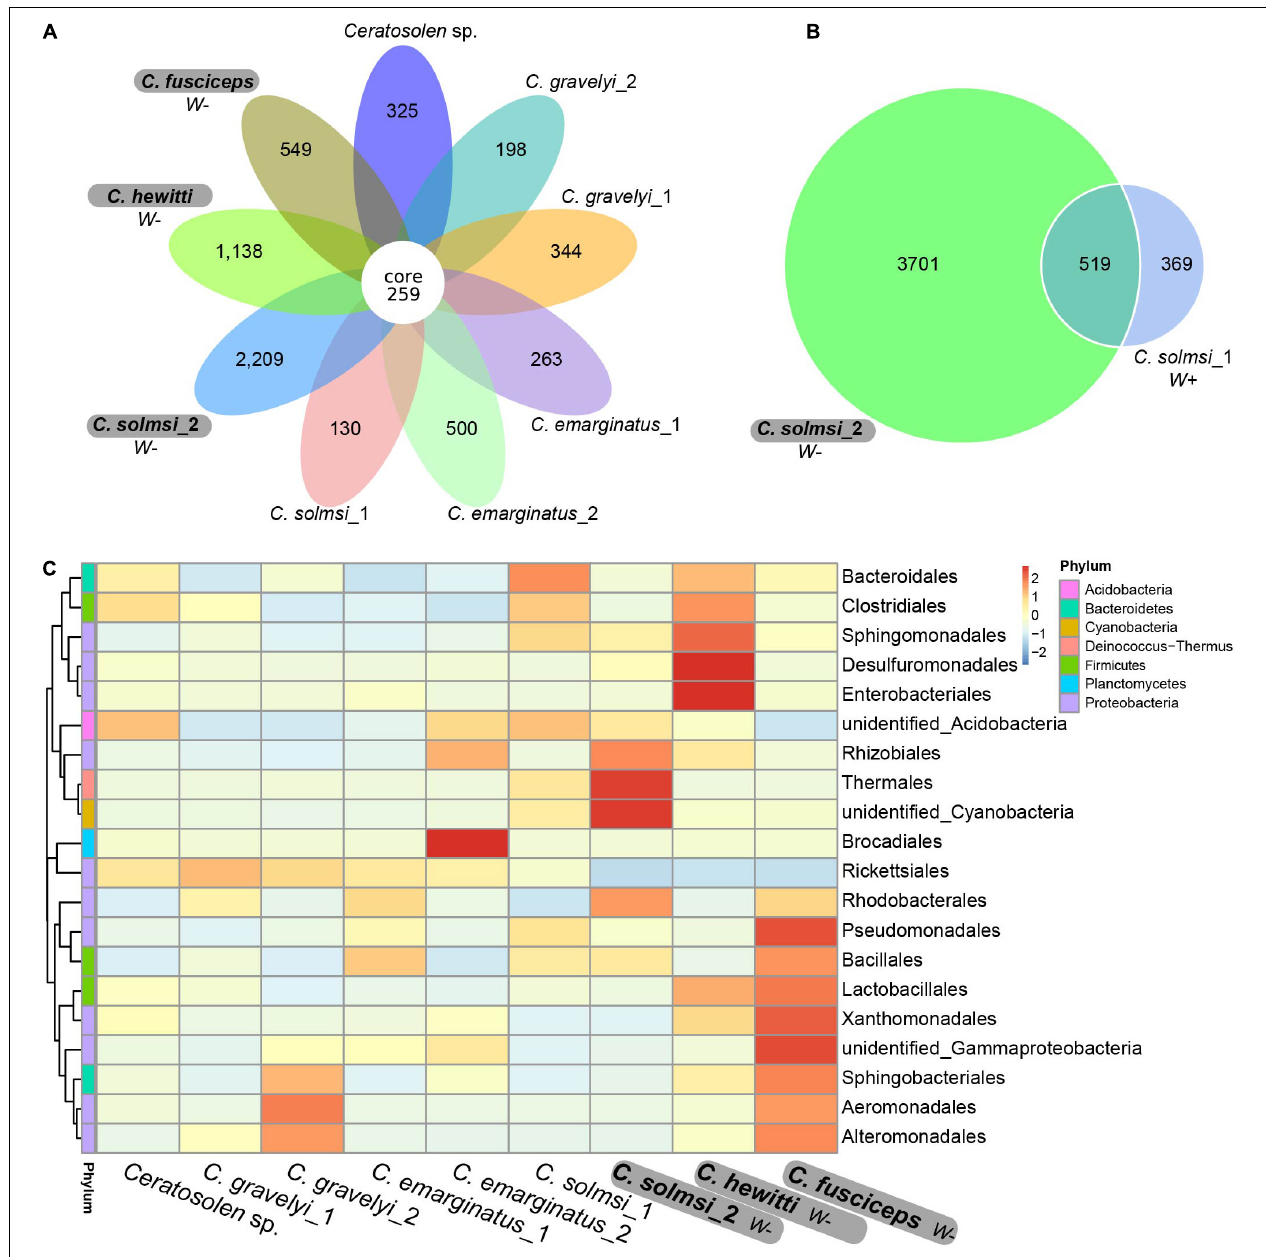
FIGURE 2 | Venn diagram and heat map. (A) Venn diagram based on all nine population. (B) Venn diagram between Wolbachia infected and uninfected group of C. solmsi . (C) Heat map of the top 20 classes in bacterial abundance. Three populations in bold are free of Wolbachia ( W –), while the other six populations are infected with Wolbachia ( W